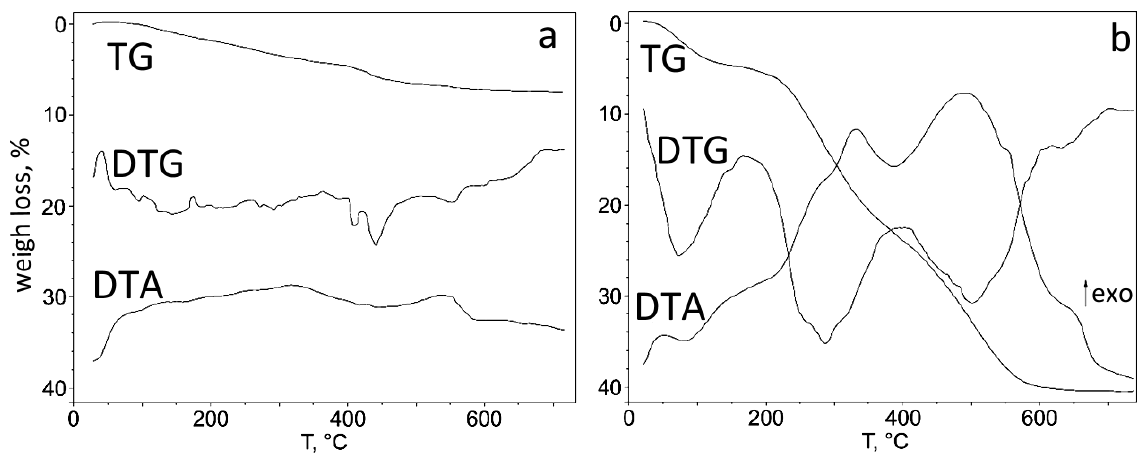
Figure 14. Thermograms of the samples 1 ( a ) and 9 ( b ) (numbers according to Table 1). Decomposition of sample 1 (Figure 4a), weight—130 mg. At the first stage (25–180 ◦ °C), water is removed and, probably, some organic component. The weight loss in this temperature range is 3.1%.